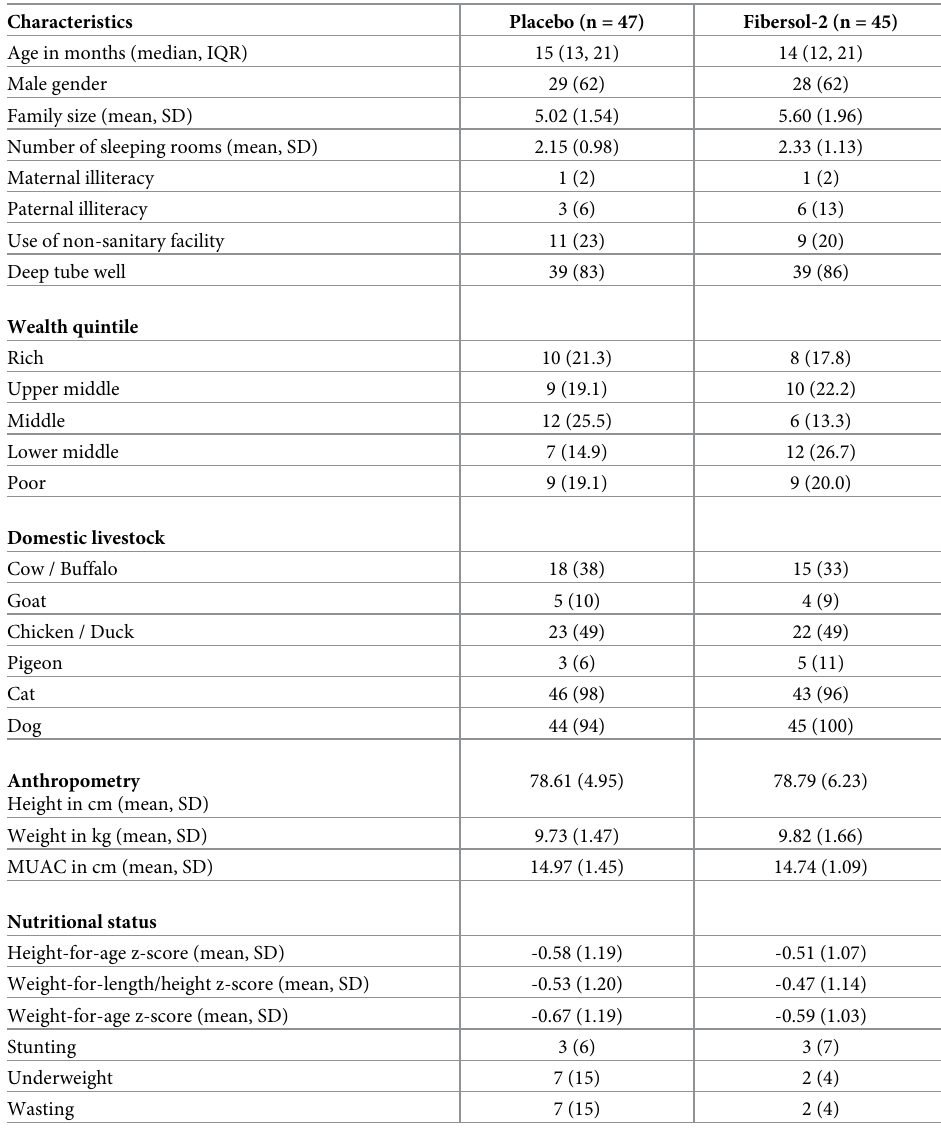
Table 1. Baseline